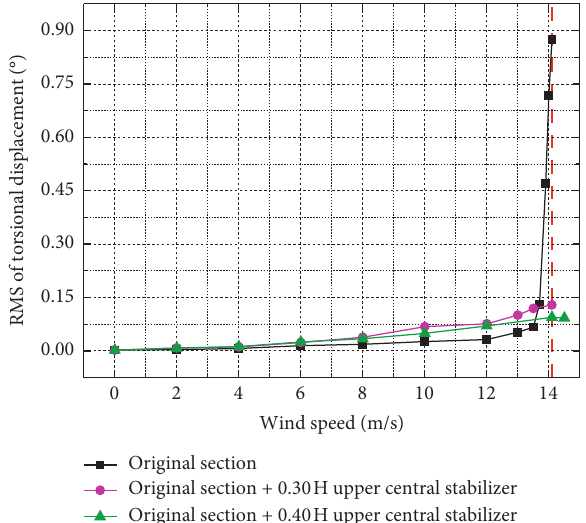
Figure 10: Mean wind pressure coefficients of lower